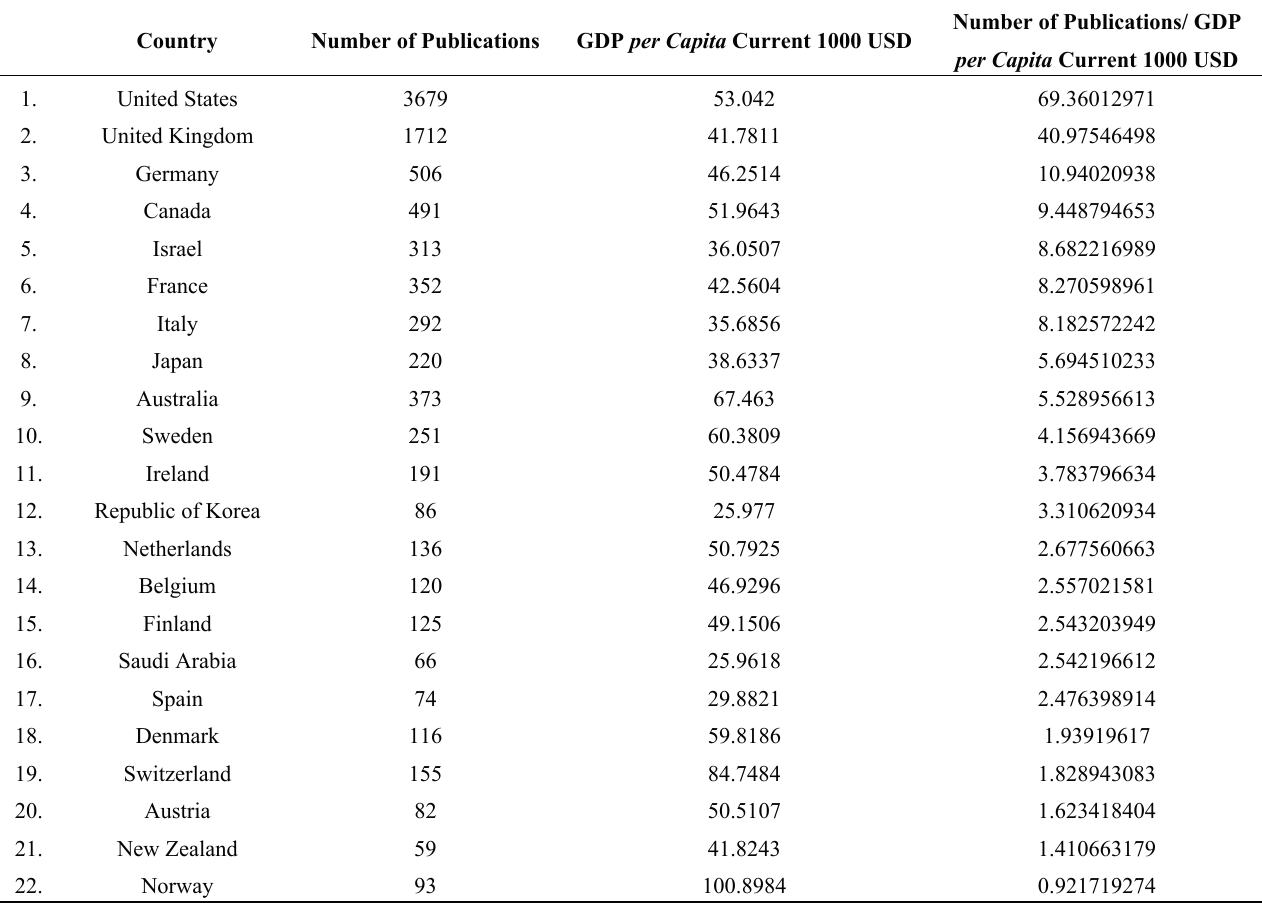
Table 3. Number of caesarean section publications/GDP per capita current 1000 USD in high-income